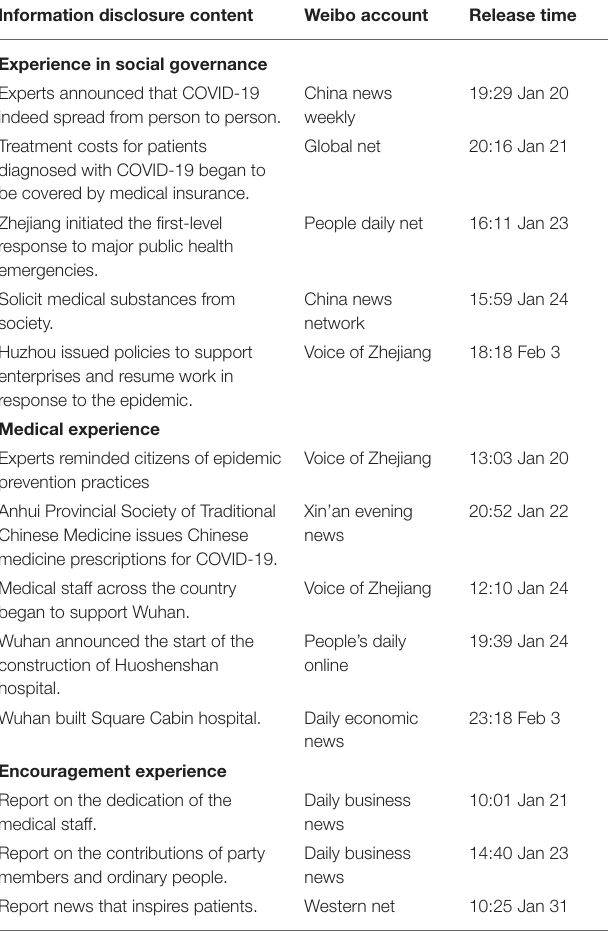
TABLE 5 | Statistical results of the disclosure time of experience